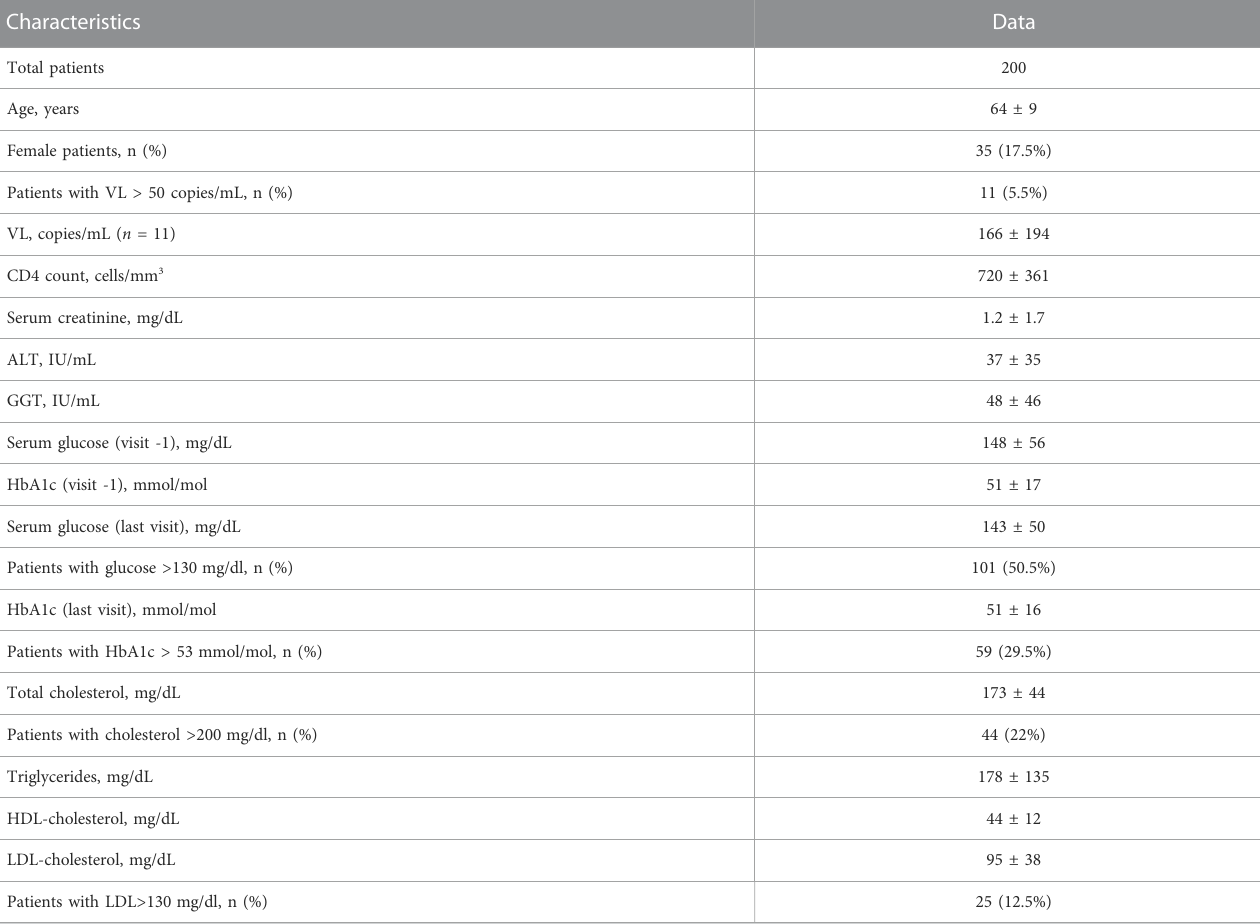
TABLE 1 Demographic and hematochemical characteristics of the 200 people living with HIV and diabetes mellitus.